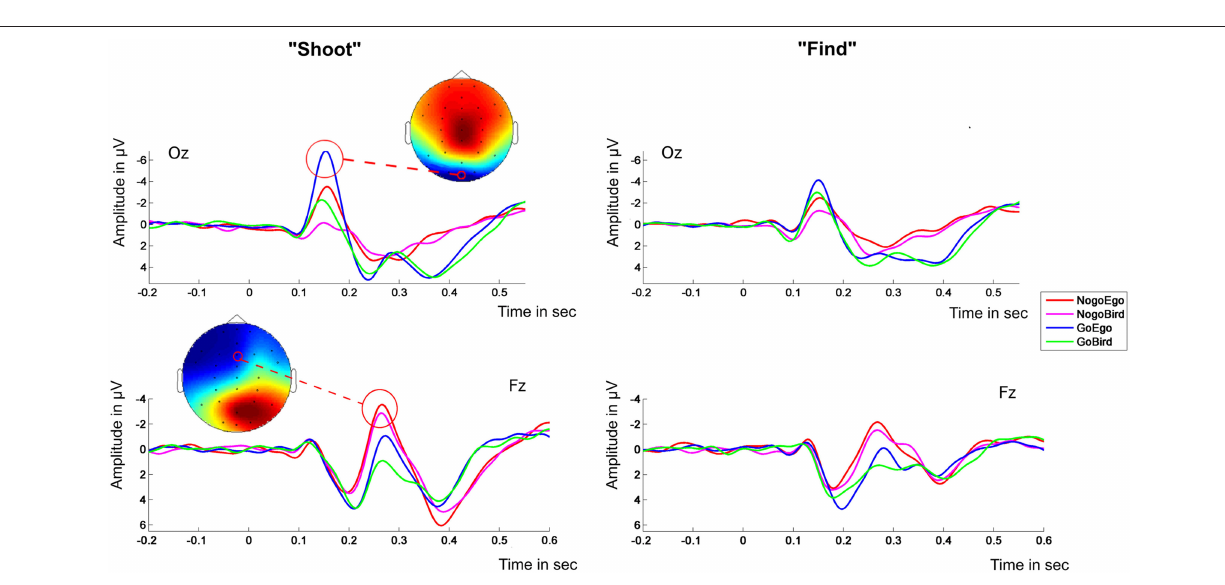
FIGURE 3 | ERP waveforms. Left panel: “Shoot”-instruction; Right panel: “Find”-instruction. Electrodes OZ (upper half) and Fz (lower half). The scalp topographies in the left panel exemplarily show the topography of the condition eliciting the highest peak at peak time ( ± 25ms). The red circle in the topography surrounds the location of the electrode of which the ERP is